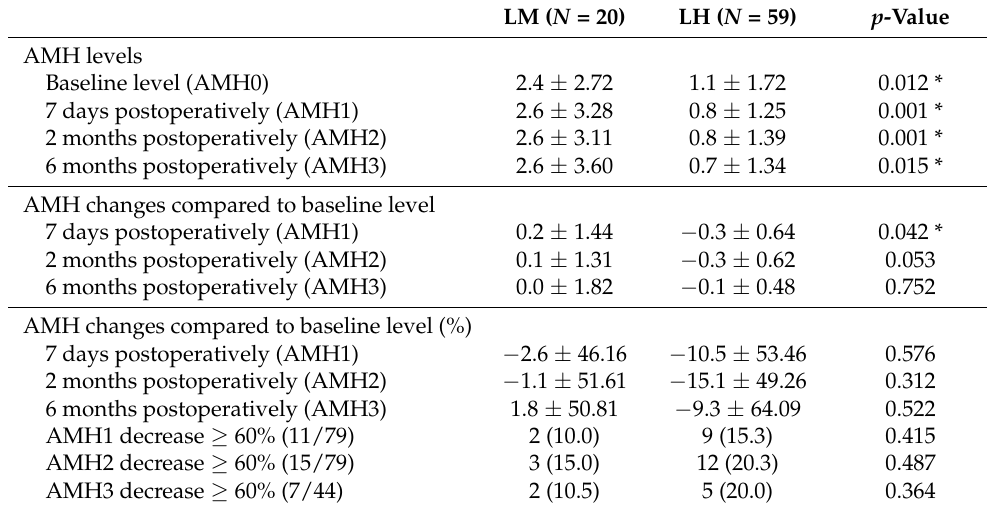
Table 2. AMH changes compared to the baseline